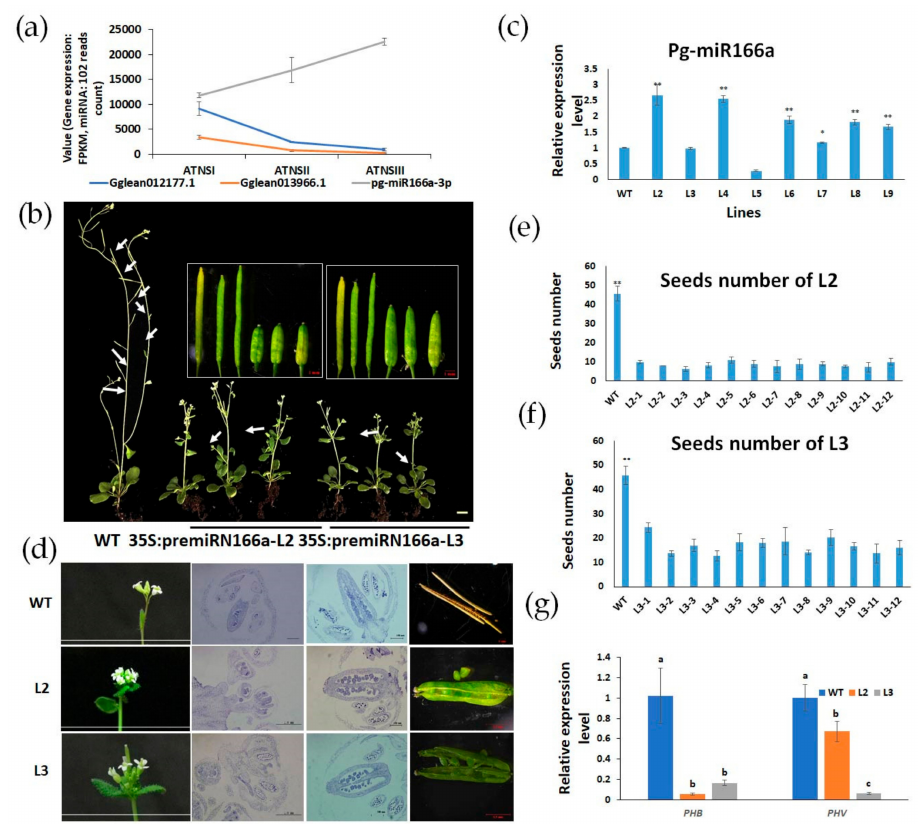
Figure 4. The phenotypes of 35S-pre-pg-miR166a-3p: ( a ) Expression level of pg-miR166a-3p, Gglean012177.1 , and Gglean013966.1 during the FMFs development; ( b ) the external morphology of 35S-pre-pg-miR166a-3p and wild type A. thaliana , the white arrow shows the location of seeds; ( c ) relative expression level of pg-miR166a-3p in di ff erent transgenic lines; ( d ) the internal morphology of 35S-pre-pg-miR166a-3p and wild type Arabidopsis; ( e ) seeds number of 35S-pre-pg-miR166a-3p line 2; ( f ) seeds number of 35S-pre-pg-miR166a-3p line 3; and ( g ) the expression level of homology genes of Gglean012177.1 ( PHB ) and Gglean013966.1 ( PHV ) in wild type A. thaliana , L2, and